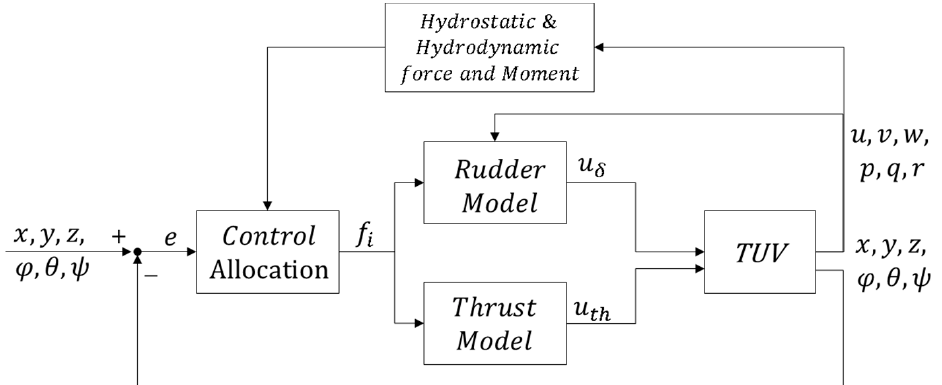
Figure 7. TUP control design.